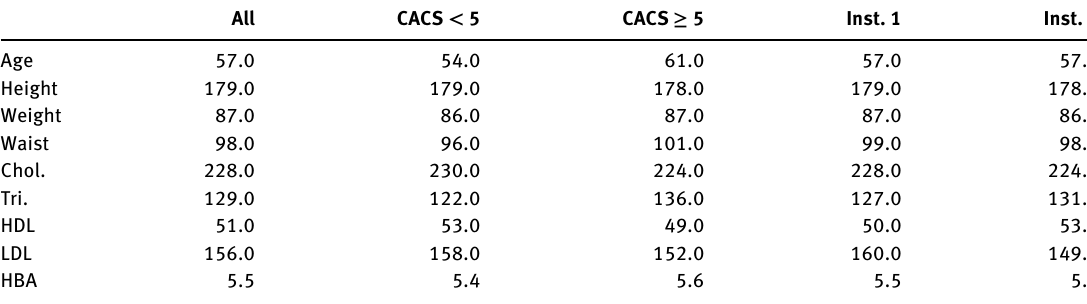
Table 2: Median values for age, height, weight, waist, cholesterol, triglycerides, HDL, LDL, HBA and BMI in the complete group, the group of patients with a CACS below and above 5, and the patients from Institution 1 and Institution 2